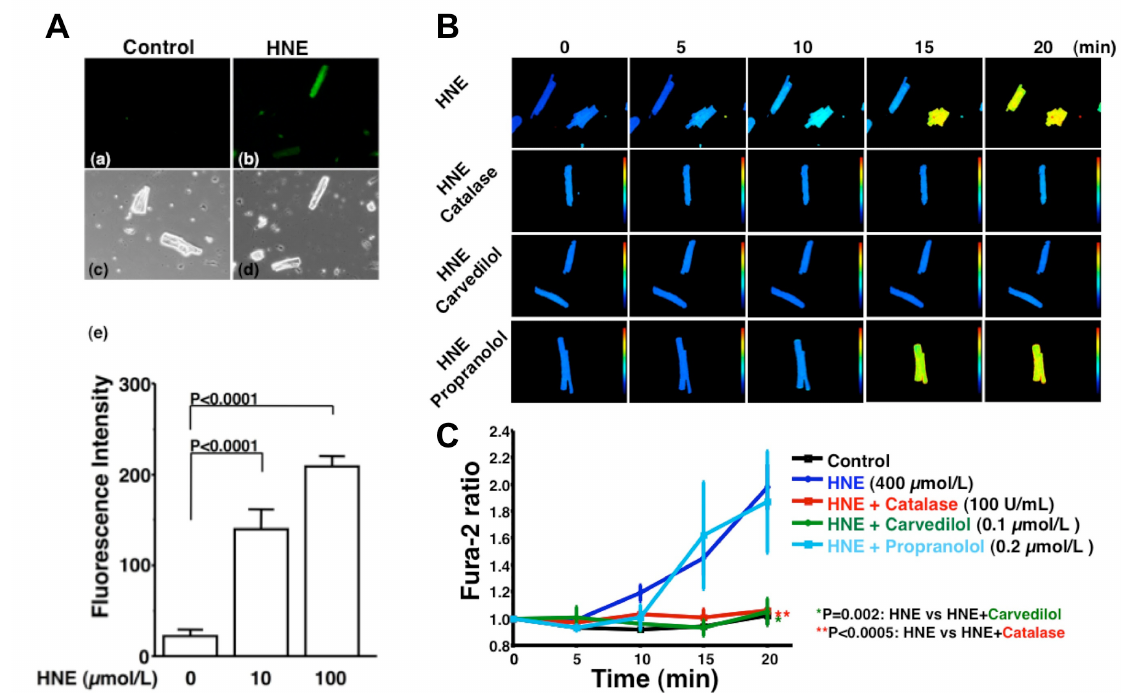
Figure 3. 4-Hydroxy-2-nonenal (HNE) induces calcium overload via the generation of reactive oxygen species in isolated rat cardiac myocytes